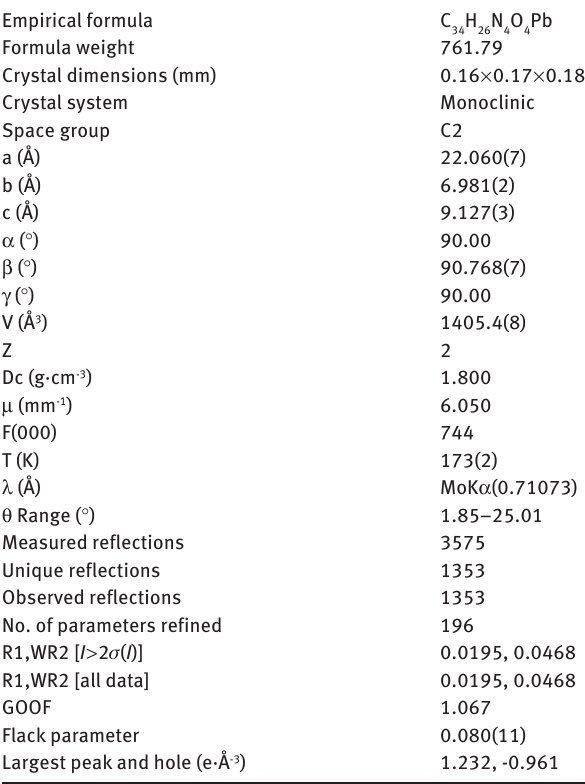
Table 3 Crystal data and refinement